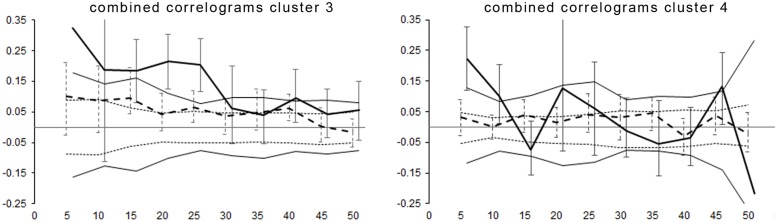
Combined spatial autocorrelation analysis for genetic clusters 3 and 4 for brown bears in Scandinavia.Distance class of 5 km (x axis); the analysis uses the multiple population approach, which sums the individual components for calculating rc as a division of the total numerator and denominator across populations, rather than the simple arithmetic mean. The genetic correlation coefficient (rc, y axis) is given as a solid thick line for females and a dashed thick line for males. The 95% confidence intervals for the null hypothesis of random distribution of genotypes, as well as bootstrap errors, are displayed correspondingly in a thin line.